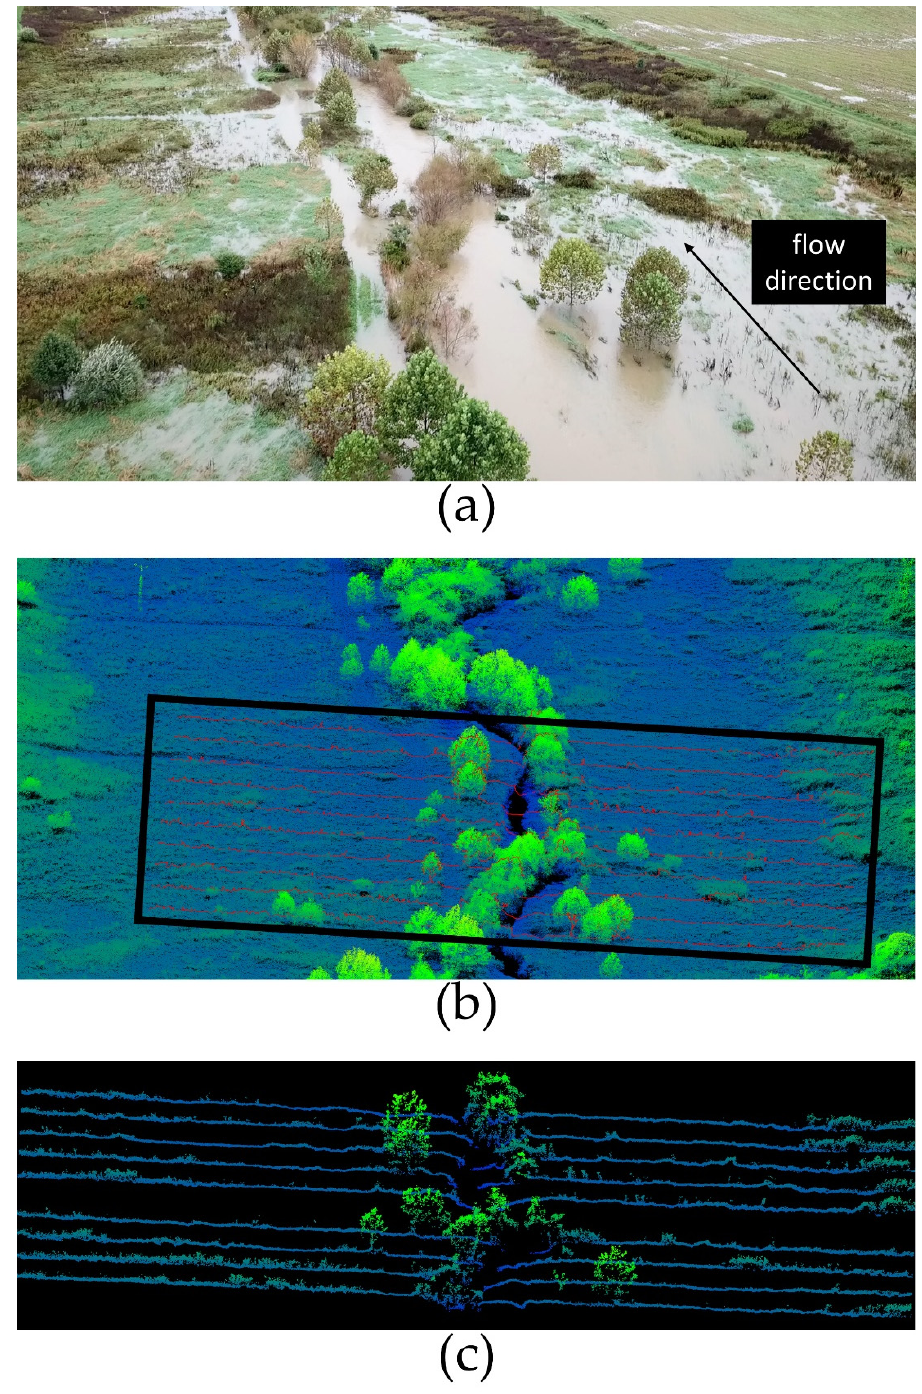
Figure 3. Visualization of StREAM Lab: ( a ) flood from Hurricane Michael on 11 October 2018, ( b ) DLS point cloud with the black rectangular box denoting where Figure 3c is located, ( c ) zoom in focusing on cross-sections taken from Figure 3b highlighting the vegetation variation across the floodplain.